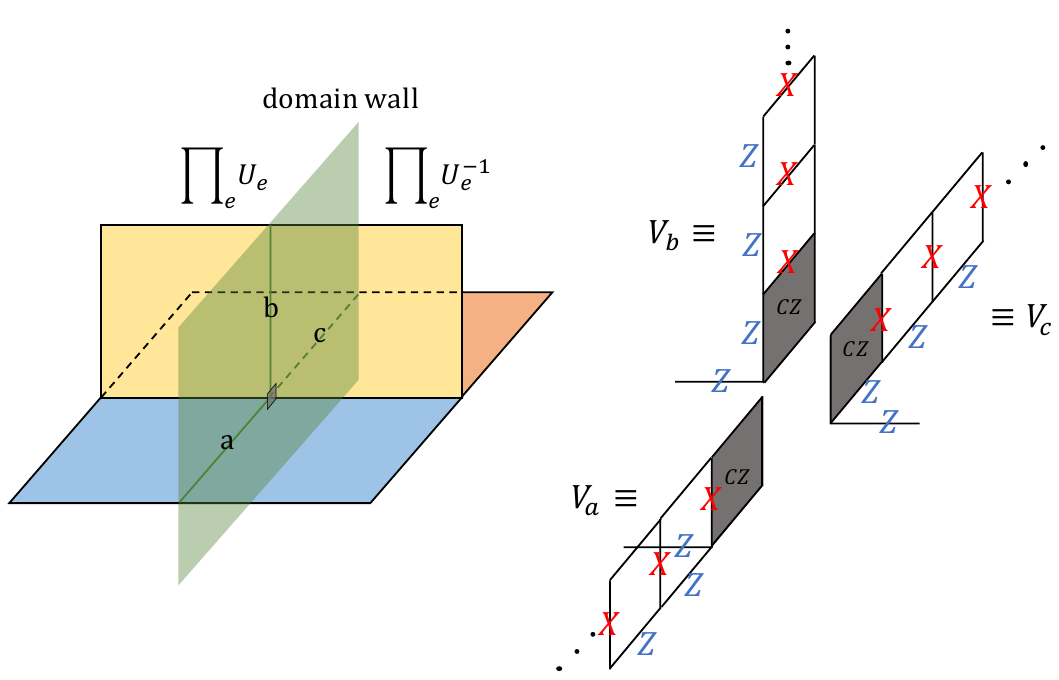
Figure 8: T junction process for the fermion hopping operator on the domain wall V V V V as in Ref. [ 51 ] , where we compare V with V and find a minus sign. This a c b b c a shows the loop excitation is fermionic. We use the ordering convention in the product of operators such that the operators that are diagonal in the Z eigenbasis (the Z and CZ operators in the figure) appear on the right of the X operators, and the product (cid:81) (cid:81) (cid:81) X Z CZ takes the form